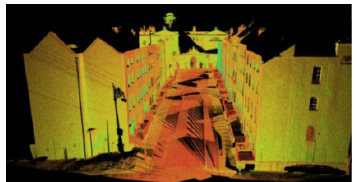
Figure 1: Laser Scan Survey of Henrietta Street